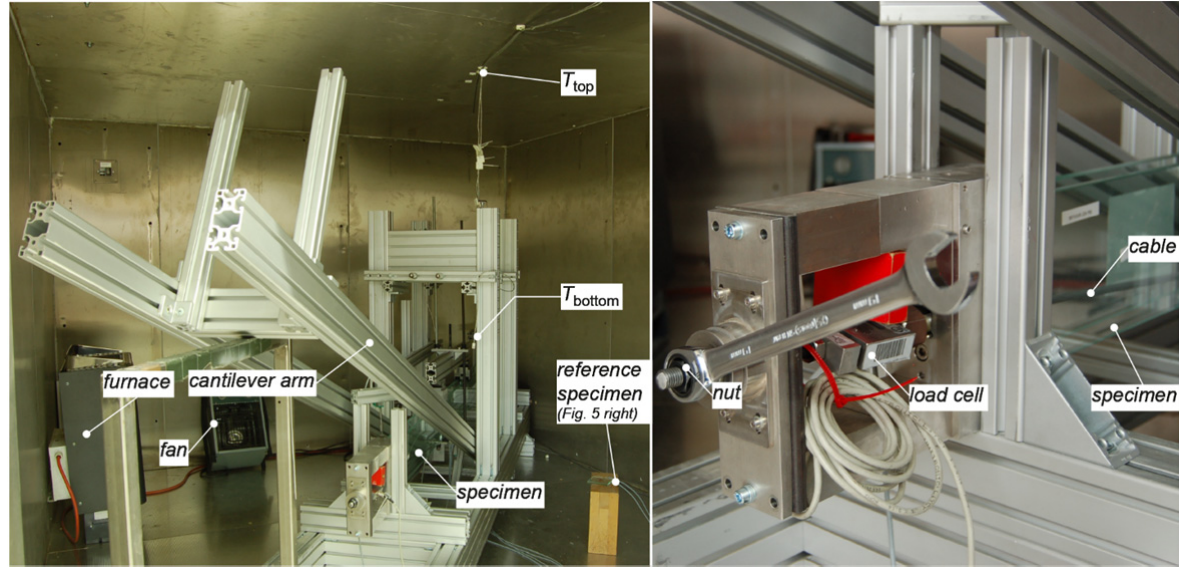
Fig. 4 Test set-up. Climate chamber with furnace and temperature sensors (left). Bearing detail (right).